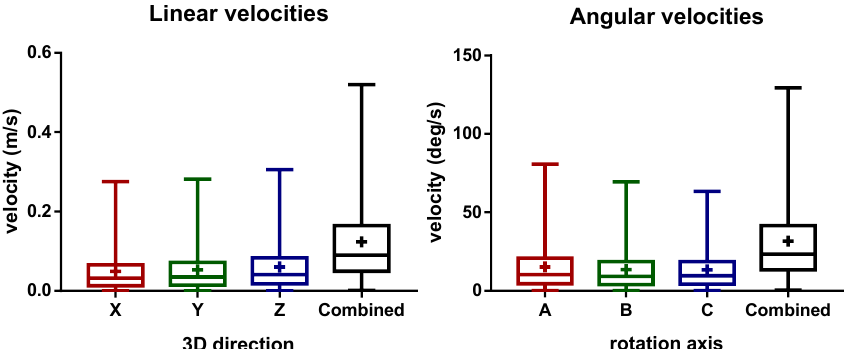
Figure 4. Boxplot results of the laser device velocities during the monitored treatment. The linear